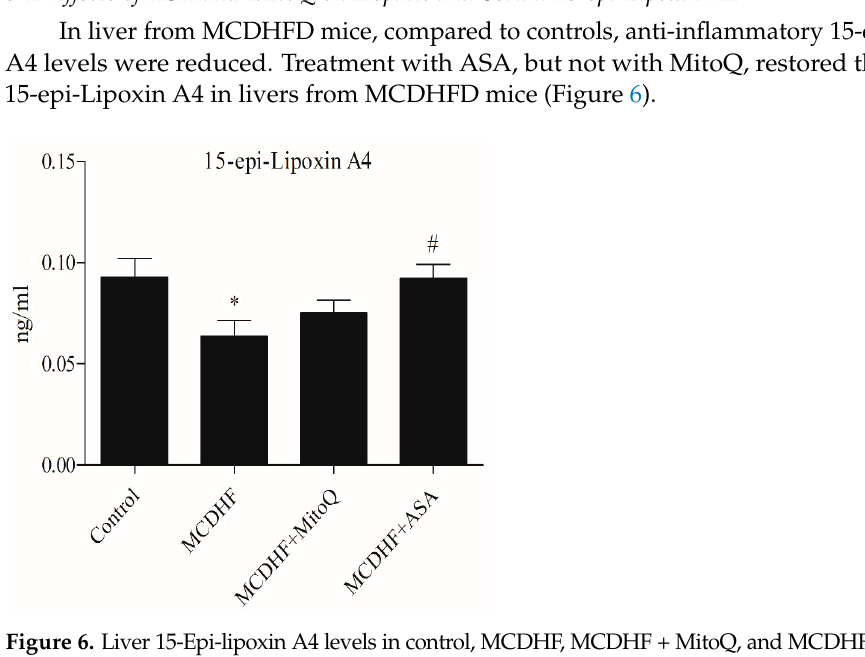
In liver from MCDHFD mice, compared to controls, anti-inflammatory 15-epi-Lipoxin A4 levels were reduced. Treatment with ASA, but not with MitoQ, re- stored the levels of 15-epi-Lipoxin A4 in livers from MCDHFD mice (Figure 6).